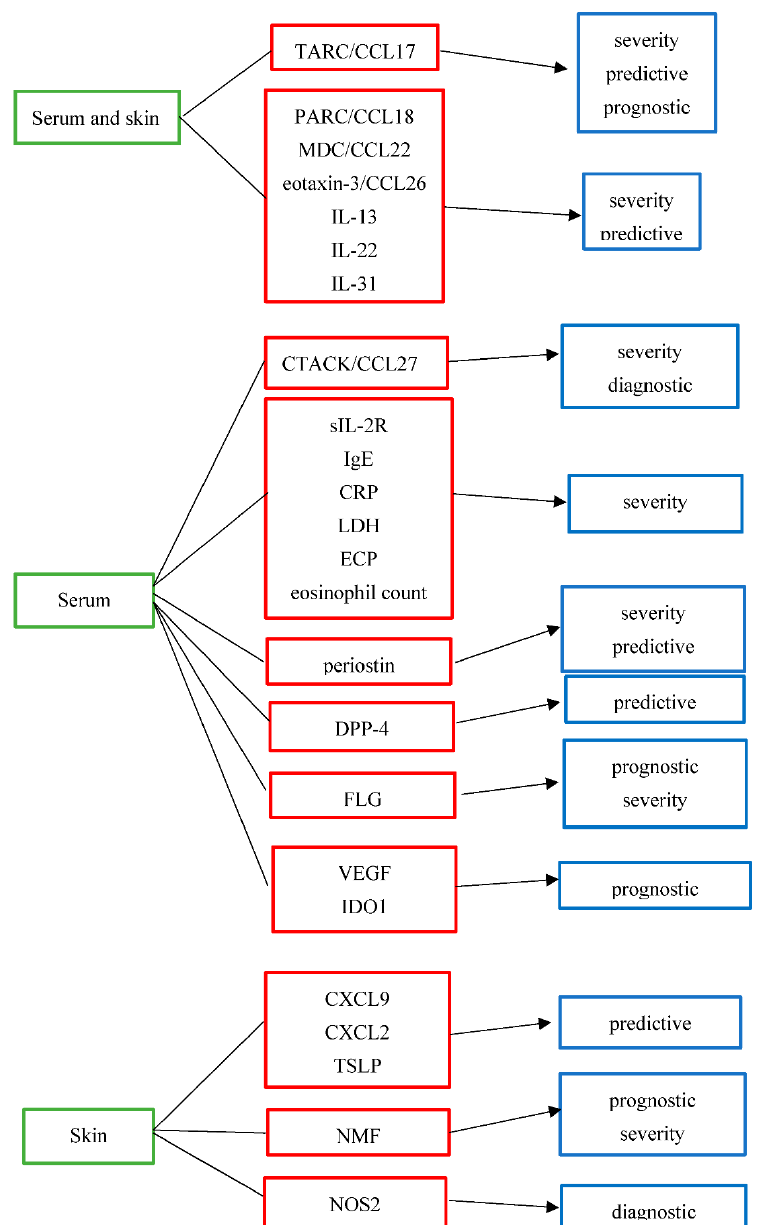
Figure 1. Biologic origin and suggested use of potential biomarkers in atopic dermatitis. TARC/CCL17: thymus and activation-regulated chemokine/C-C motif ligand 17, PARC/CCL18: pulmonary and activation-regulated chemokine/C-C motif ligand 18, MDC/CCL22: macrophage-derived chemokine/C-C motif ligand 22, eotaxin-3/CCL26: eosinophil-attracting chemokine/C-C motif lig- and 26, IL-13:interleukin-13, IL-22:interleukin-22, IL-31:interleukin-31, CTACK/CCL27:cutaneous T- cell-attracting chemokine/C-C motif ligand 27, sIL-2R:soluble IL-2 receptor, IgE:immunoglobulin E, CRP:C-reactive protein, LDH:lactate dehydrogenase, ECP:eosinophil cationic protein, DPP- 4:dipeptidyl peptidase-4, FLG:filaggrin, VEGF:vascular endothelial growth factor,